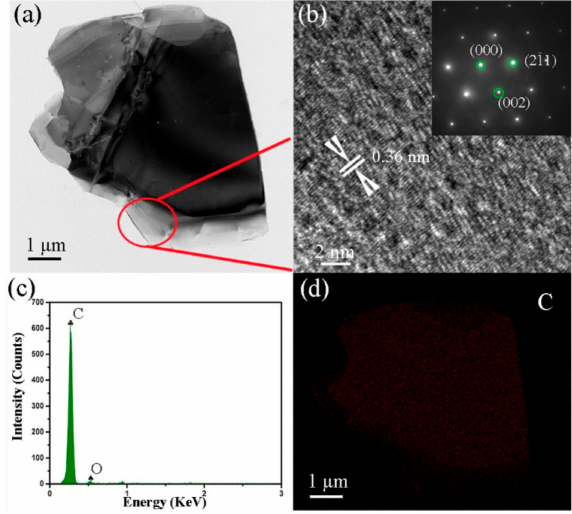
Figure 4. ( a ) Transmission electron microscope (TEM) image of exfoliated micro / nano-sized graphite sheets, ( b ) high resolution transmission electron microscope (HRTEM) image and di ff raction pattern (inset), ( c ) energy spectrum of area, and ( d ) mapping of area.